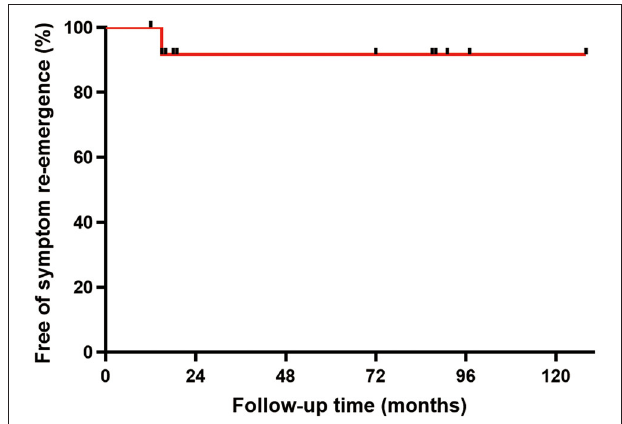
FIGURE 4 | Symptom re-emergence free analysis. As shown in the survival curve, the overall no-recurrence rate was 93.3%